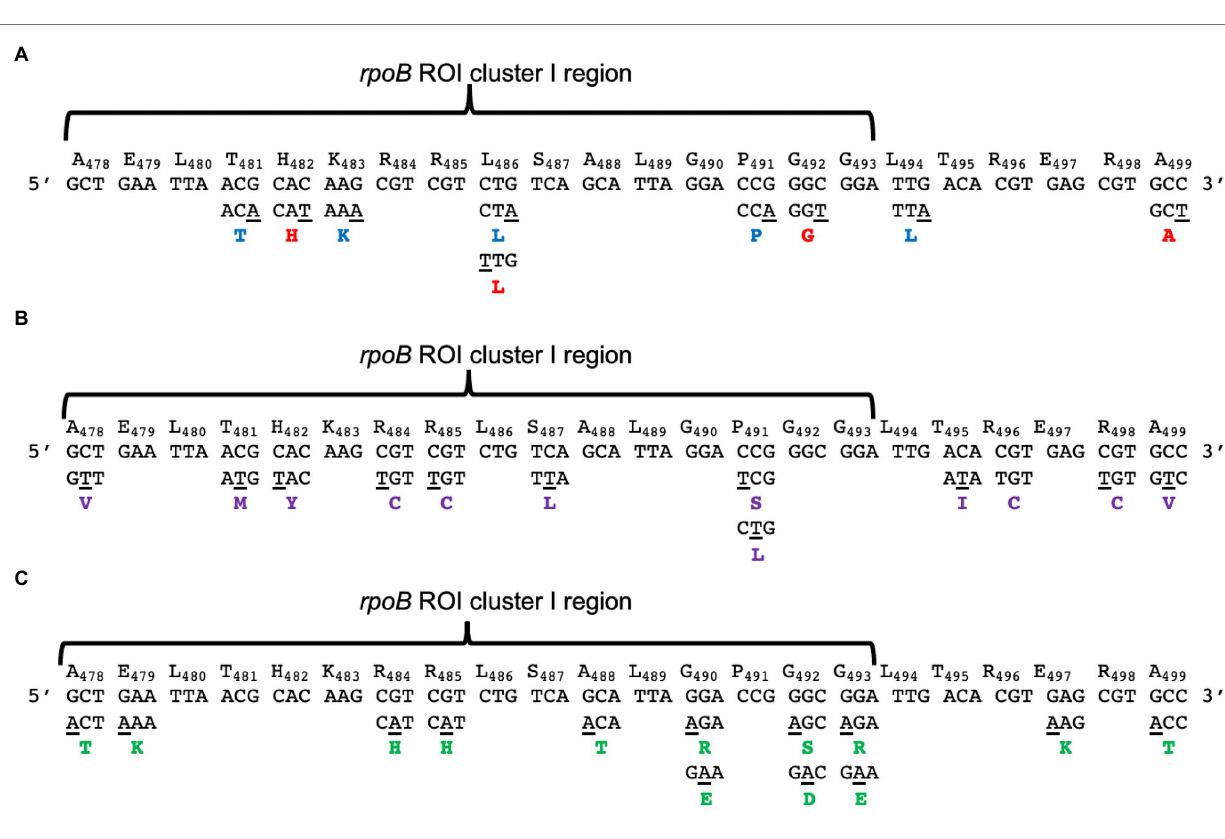
FIGURE 7 | Spectrum of C → T and A → G transitions leading to silent (A) and aminoacidic changes (B,C) identified by MDS in the rpoB ROI. Each scheme (A–C) shows the WT codons and position of the encoded amino acids in the rpoB ROI analyzed. The base substitutions are shown underlined in the mutated codon below the WT codons. The amino acid changes (in the single letter format) are shown in bold type, below the mutated codons. Silent mutations (A) derived from G → A and C → T substitutions are shown in blue and red bold type, respectively. Aminoacidic changes derived from C → T mutations (B) are shown in purple bold type letter below each mutated codon. Aminoacidic changes derived from G → A transitions (C) are shown in green bold type letter below each mutated